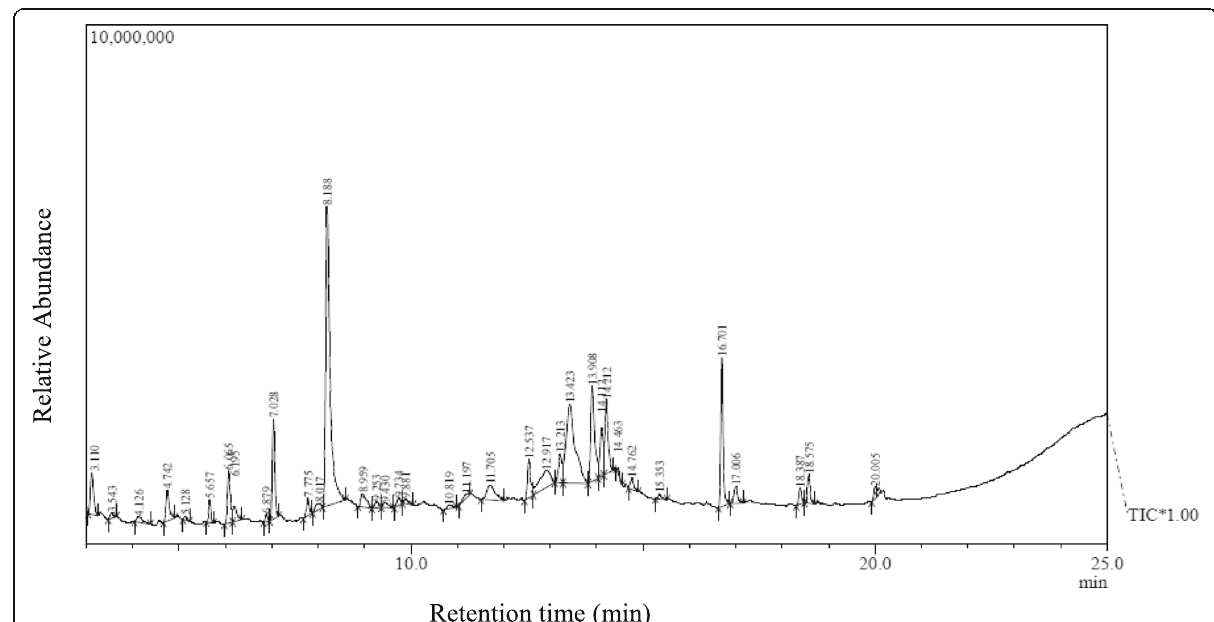
Fig. 1 GC-MS chromatogram of Gardenia gummifera L.f. fruit methanol